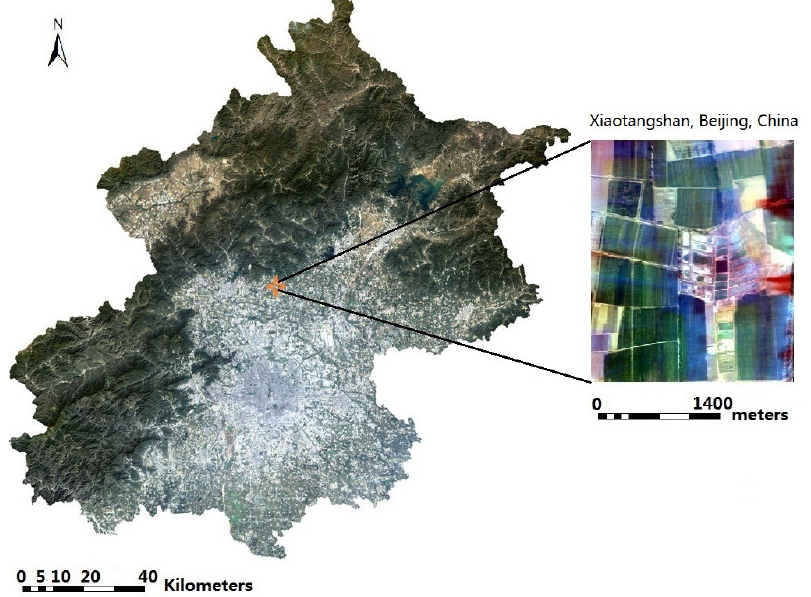
Figure 1. The study area at Xiaotangshan, Beijing, China (OMIS true color synthesis image, R = 699.2 nm, G = 565.4 nm, B = 465.0 nm).